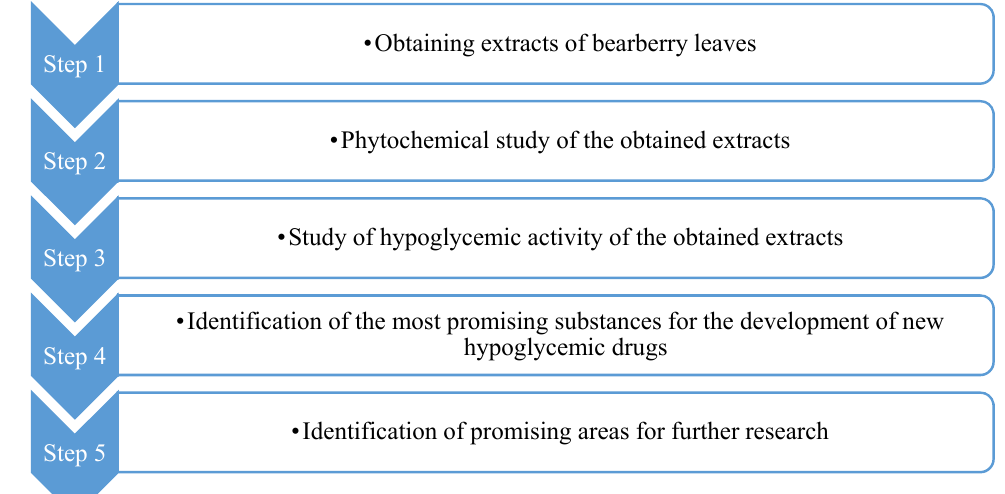
Fig. 1. Scheme of research of extracts from bearberry